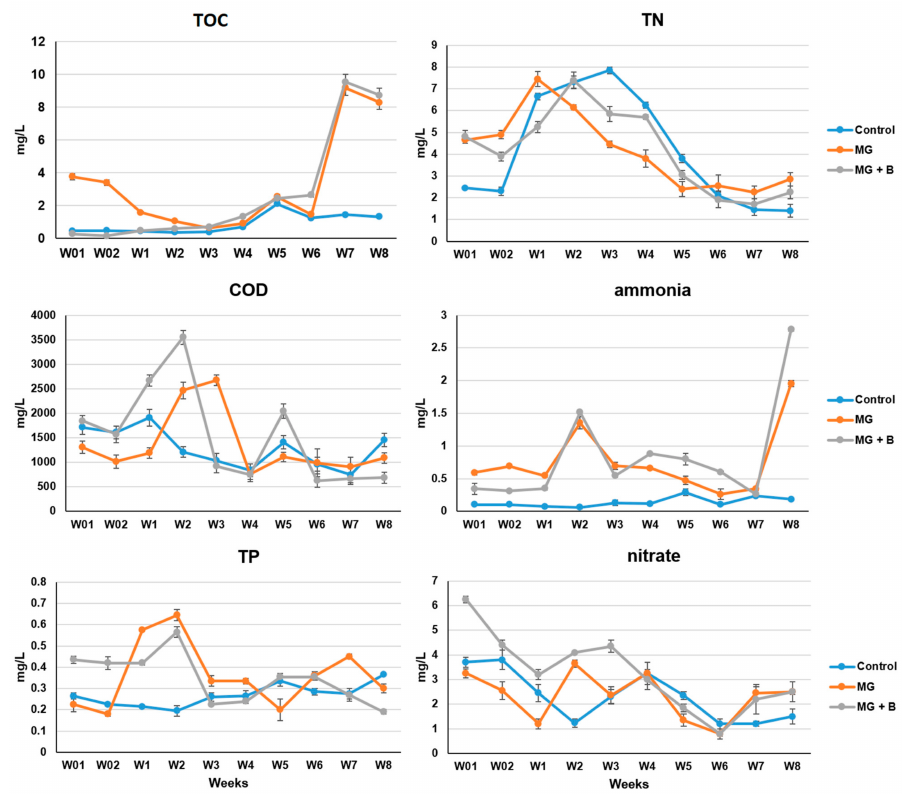
Figure 2. Chemical compositions of water in small milkfish ponds. COD: chemical oxygen demand. TOC: total organic carbon. TP: total phosphorous. TN: total nitrogen. Data from three independent measurements are presented as the mean ± SE. Control: control small milkfish pond. MG: small milkfish pond with the addition of MG. MG+B: small milkfish pond with the addition of MG and MG-degrading bacteria. W01 and W02: two weeks before the experiment. W1-W8: the first to the 8th week after the start of the